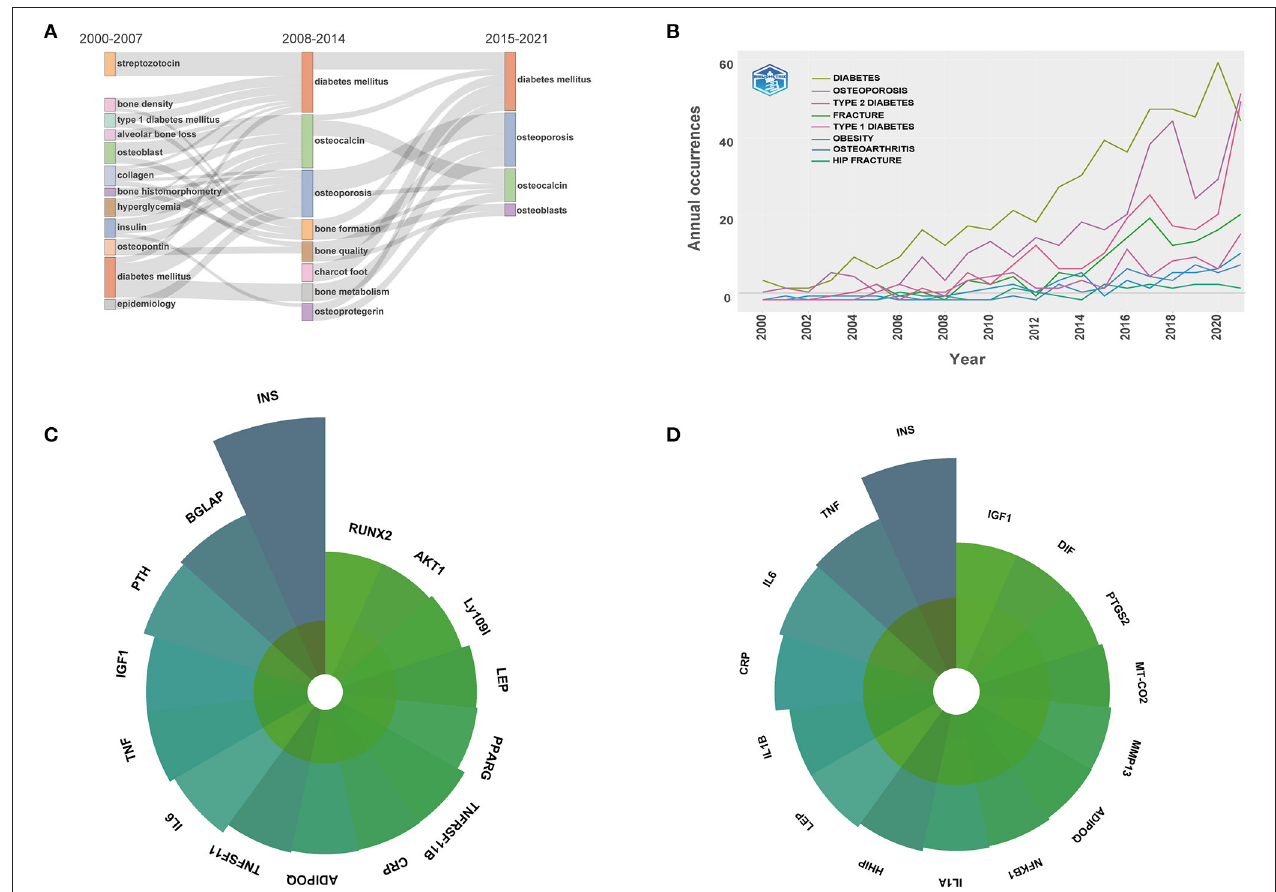
FIGURE 10 | (A) Thematic evolution of the three stages in the BMDM research field. The line between nodes reflects the research topic’s evolving focus. The width indicates the amount of shared keywords. The thicker the line, the greater the significance of the two subjects. (B) The change pattern of annual occurrences frequency of author keywords related to disease. (C) Top 15 most studied genes between osteoporosis and diabetes mellitus. (D) Top 15 most studied genes between osteoarthritis and diabetes mellitus.